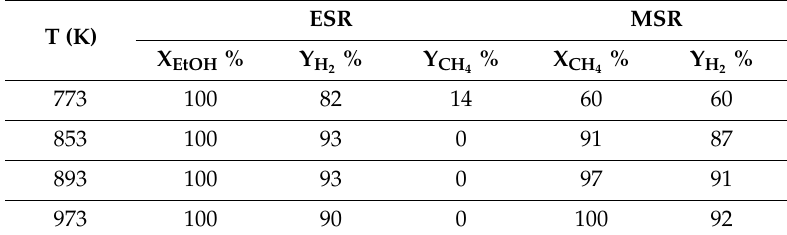
Table 5. Reactants conversion and the product yields in ethanol steam reforming (ESR) and methane steam reforming (MSR) over the commercial Ni / Calcium aluminate